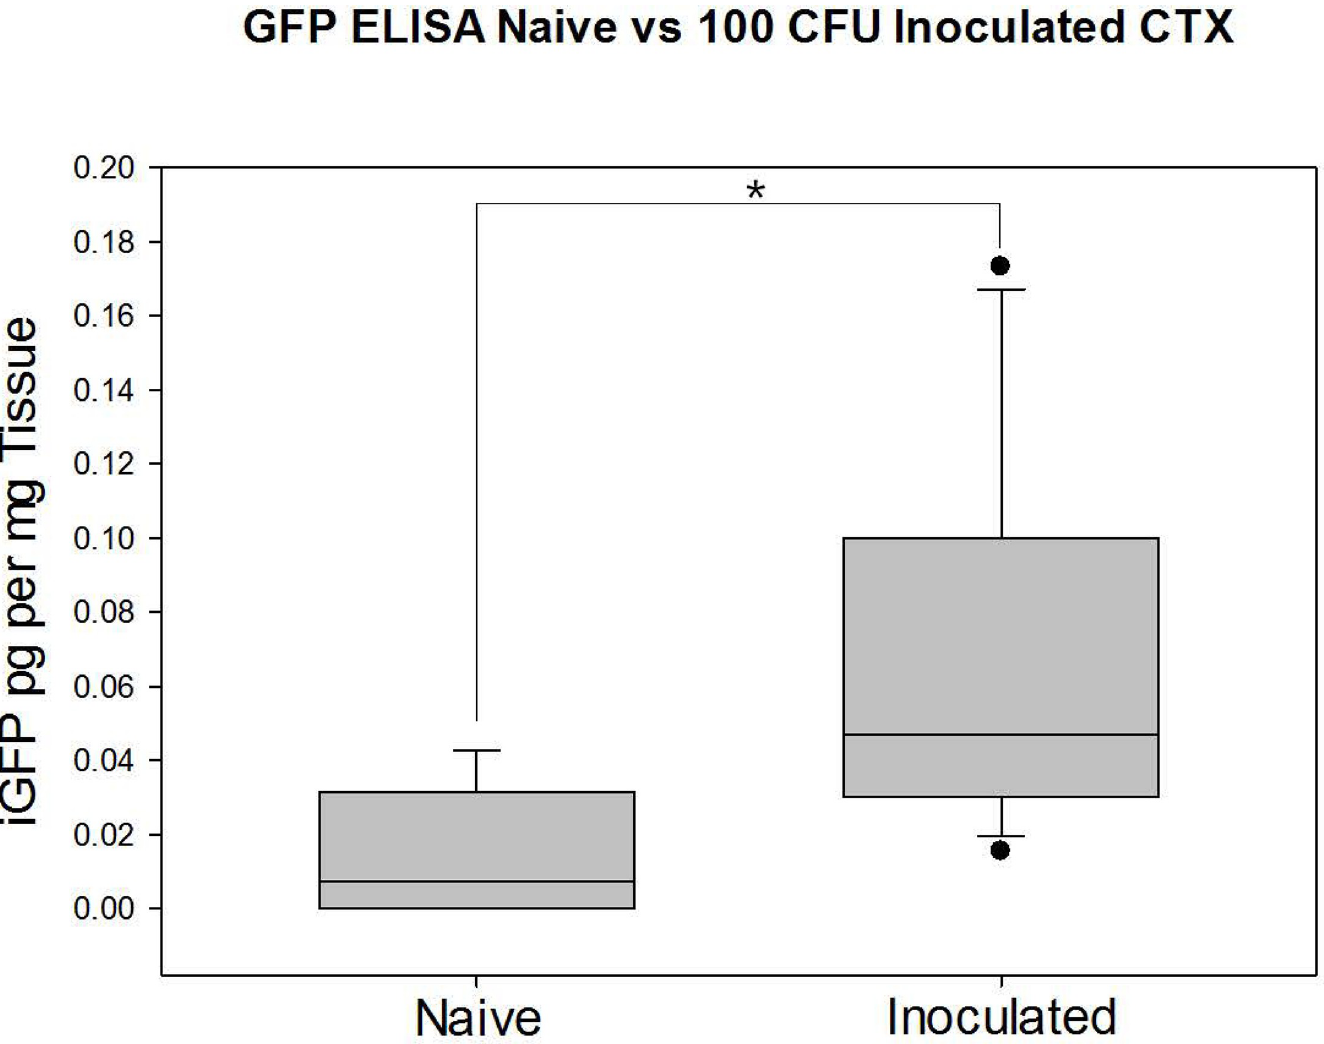
Fig 2. Immunoreactive GFP (iGFP) as measured by ELISA in cerebral cortex of fetuses from na ï ve (n = 6) and 100 cfu-inoculated (n = 14) pregnancies. Measured values of iGFP are significantly different between the two groups (p = 0.005).